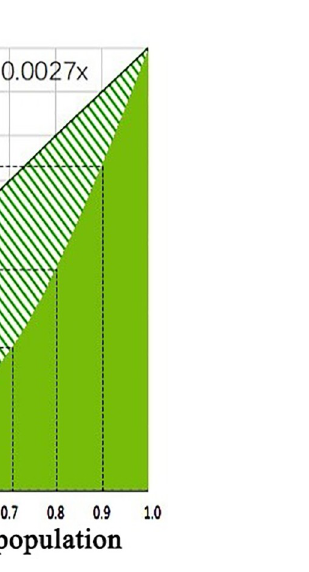
Fig 5. Lorenz curve of resource allocation of public sports facilities.